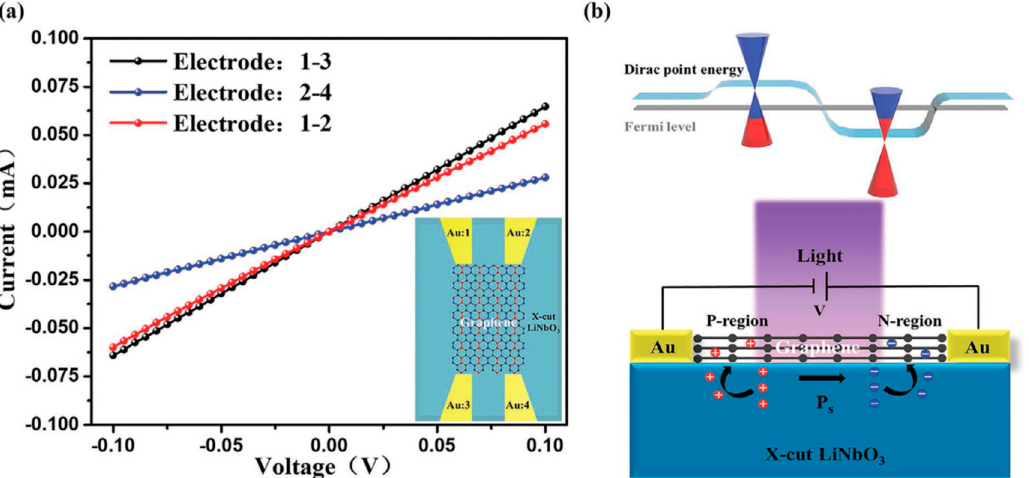
Figure 7. ( a ) The current–voltage (I–V) curve of the sample in the same environment. The black, blue, and red color lines represent measurements between electrodes 1–3, electrodes 2–4, and electrodes 1–2, respectively (cf. inset). ( b ) Band diagrams of the device at the p − n junction state [62].